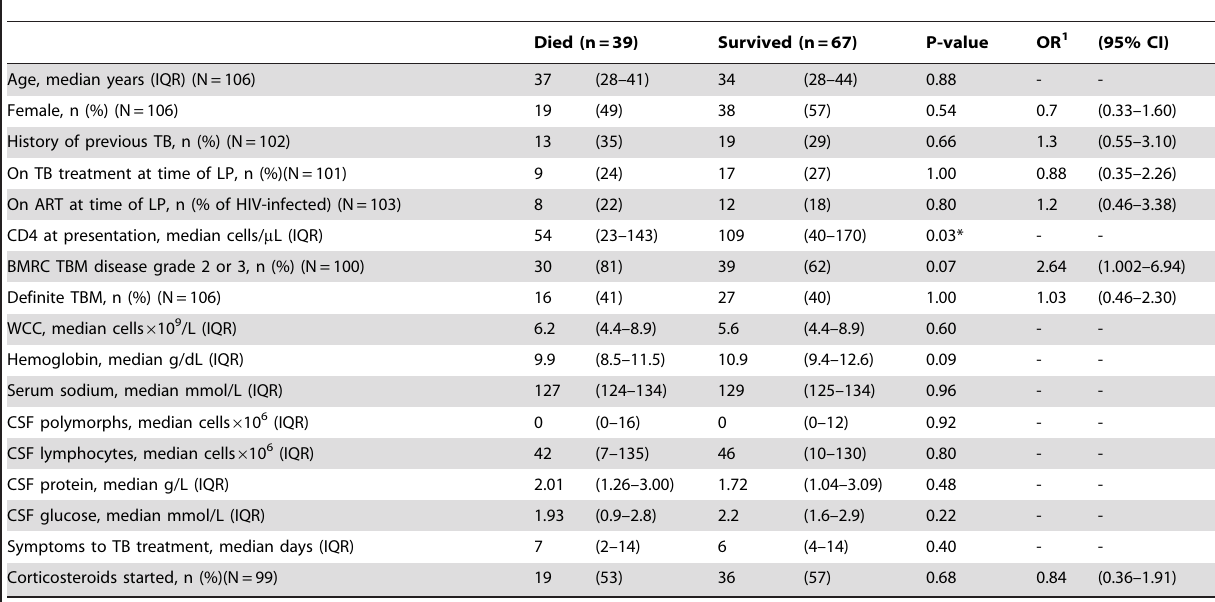
Table 5. Univariate analysis of variables associated with inpatient mortality in HIV-infected patients with definite, probable and possible tuberculous meningitis